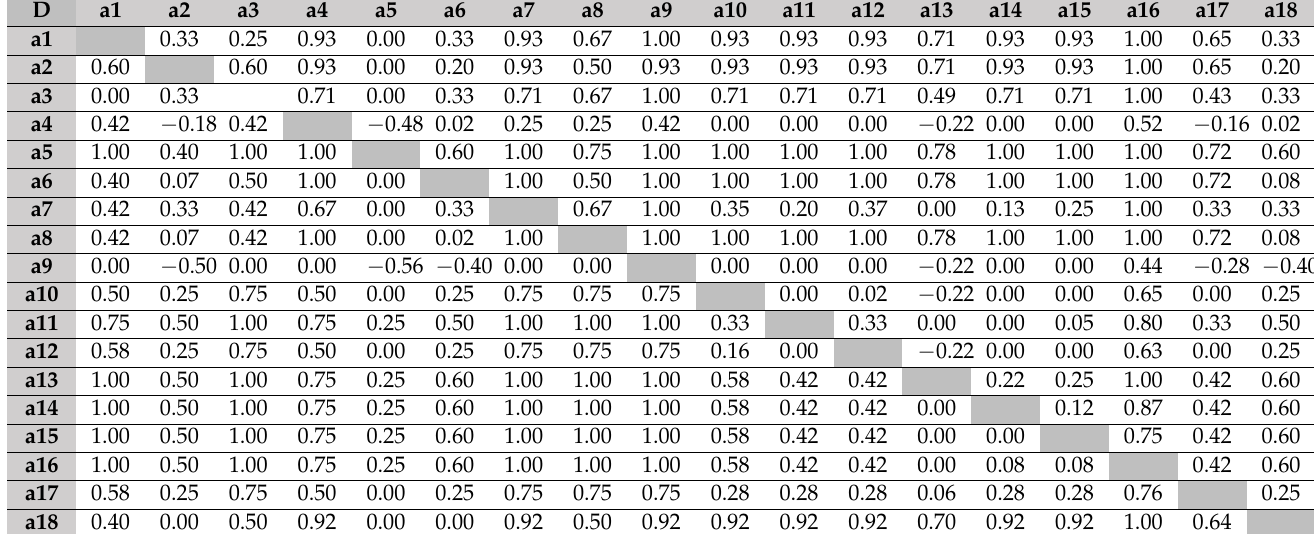
Table 14. Discordance matrix generated by pairwise comparison of all